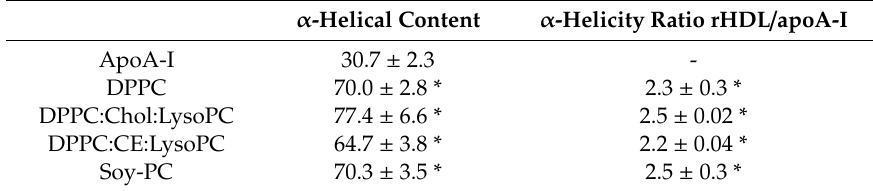
Table 1. α -helical content of apoA-I and rHDL determined by CD. α -Helical Content α -Helicity Ratio rHDL / apoA-I ApoA-I